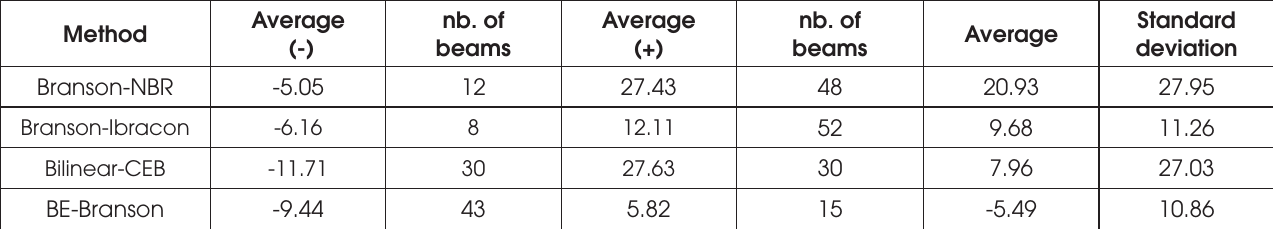
Average of percentage differences (in %) between the final deflections found by the different methods and the reference model, AM